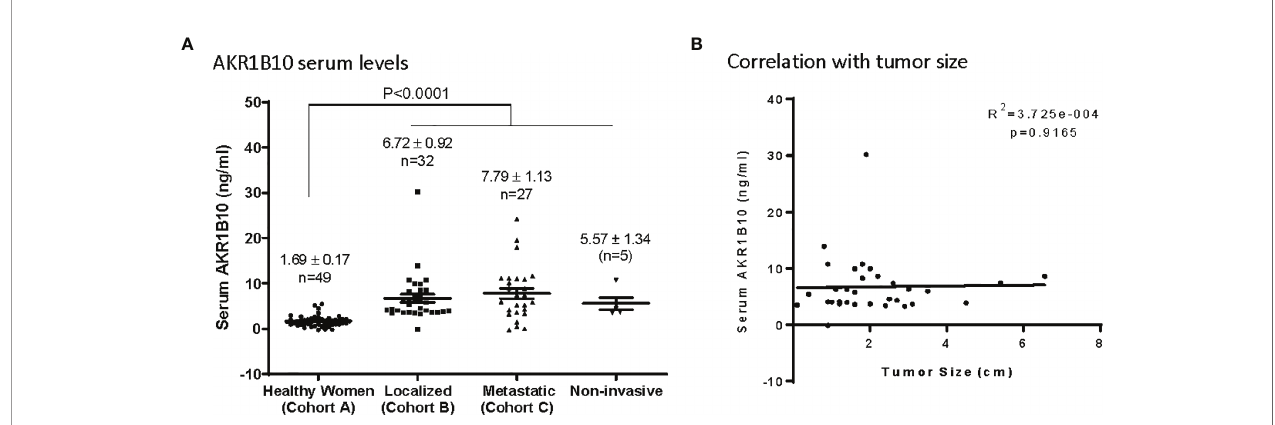
FIGURE 2 | Serum levels of AKRlBlO in Breast Cancer patients. (A) AKR1B10 serum levels in healthy women and patients with localized, metastatic, or noninvasive disease. Serum AKR1B10 levels were signi fi cantly higher in breast cancer patients than that in healthy women. (B) Serum AKR1B10 levels in localized breast cancer patients failed to show any direct correlation with the